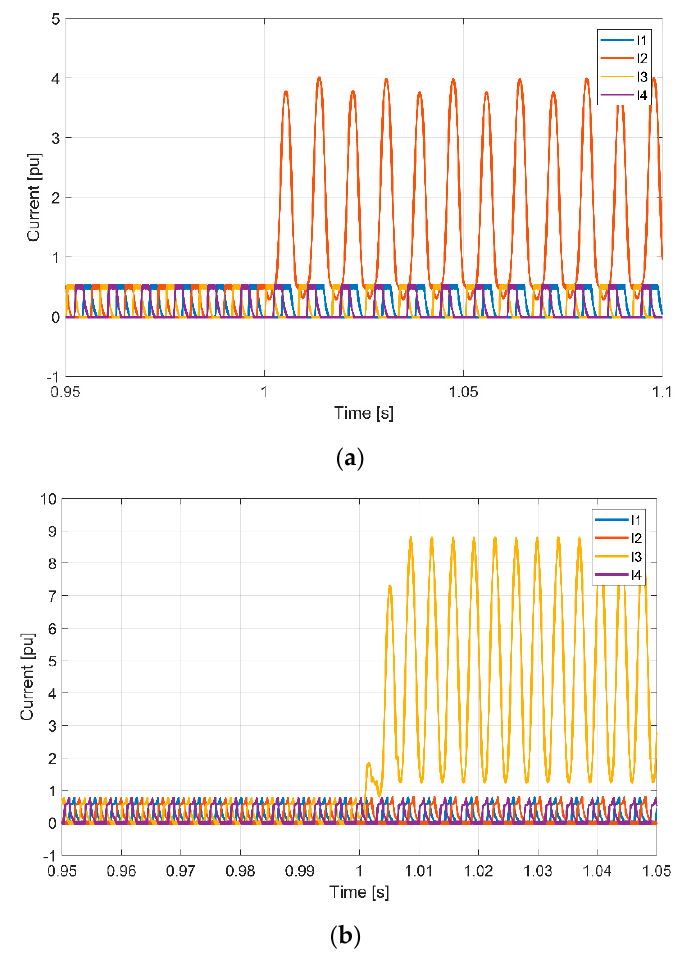
Figure 16. Motor winding currents of the SRM in normal operation and short-circuit failure of power device ( a ) 1200 rpm and S 1 B ( b ) 2850 rpm and S 1 C (simulation result).